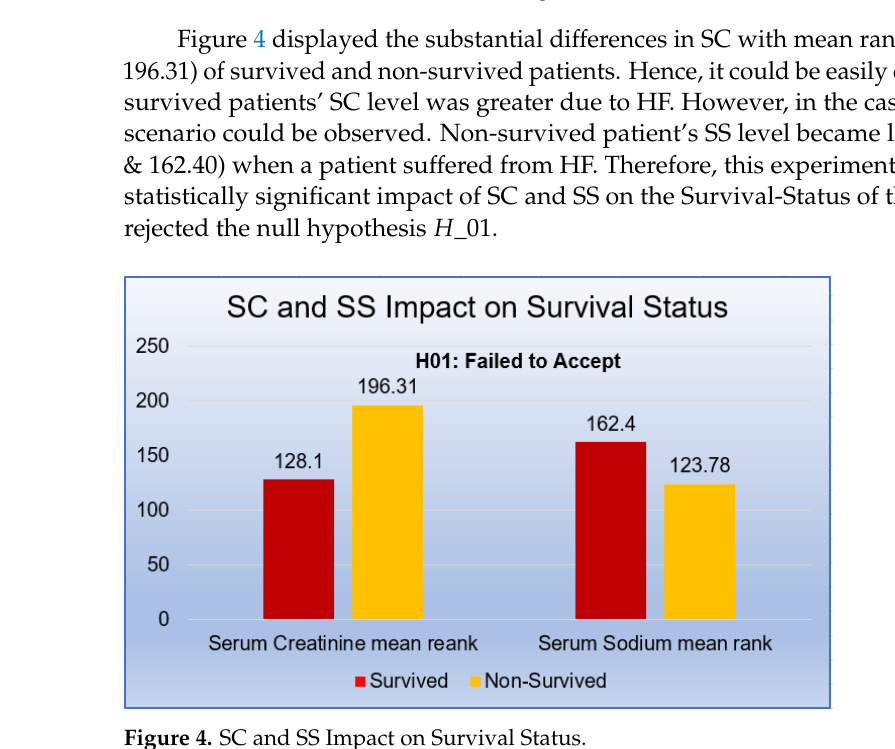
Figure 4. SC and SS Impact on Survival Status.